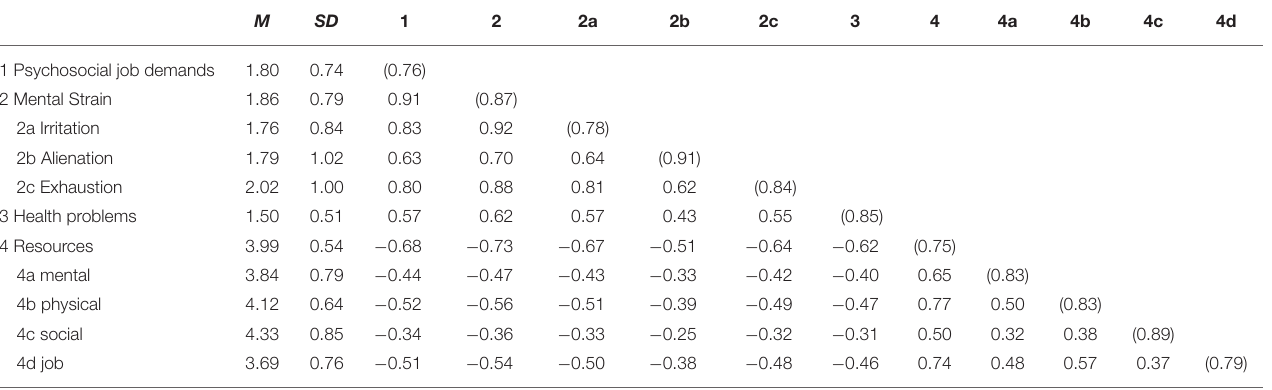
TABLE 1 | Descriptive statistics and the model-implied correlation matrix of the latent variables. M